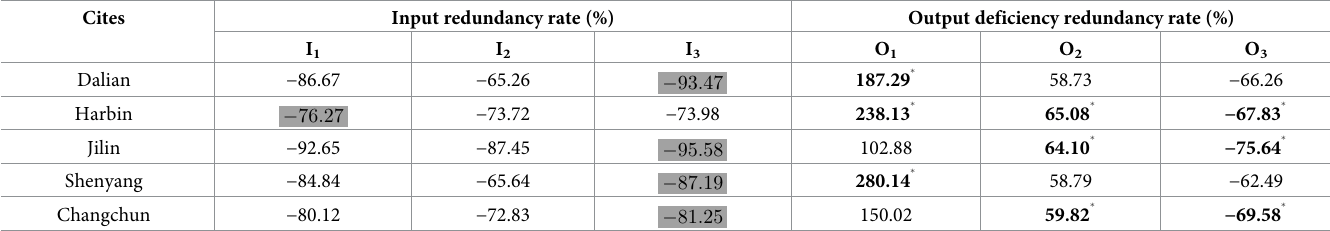
Note: In Table 5, I 1 refers to investment in fixed assets, I 2 refers to employees in the tertiary industry, I 3 refers to foreign direct investment, O 1 refers to total tourism income, O 2 refers to total tourism population and O 3 refers to PM2.5 emission concentration. 1) The negative number in the table represents that this indicator is redundant, and the positive number represents that this indicator is insufficient. Redundancy (deficiency) rate refers to the absolute value of the corresponding value of each indicator. 2) The dark colour blocks in the table represent the indicator ranking first in the redundancy rate. 3) The figures with ‘ � ’ in the output indicators correspond to the cities in the top three of deficiency (redundancy) rate.